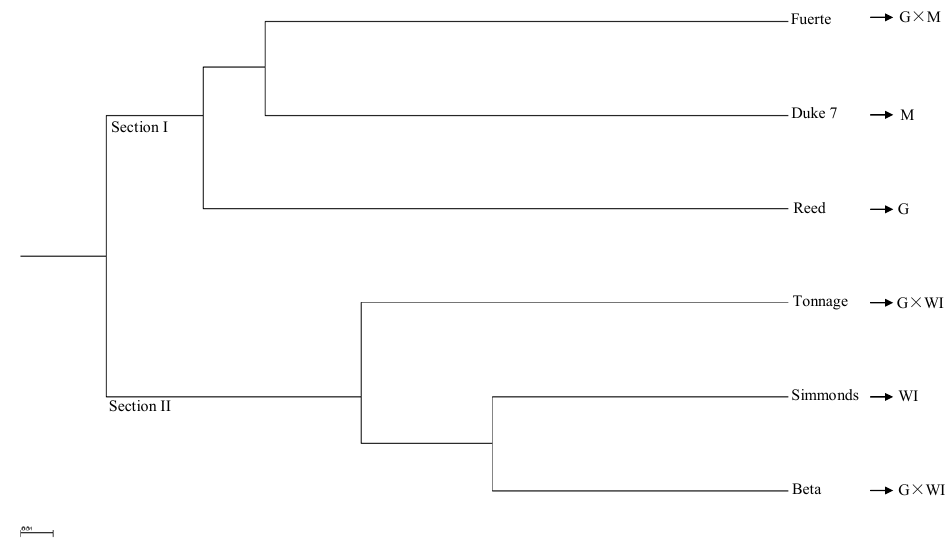
Figure 4. Unrooted unweighted pair-group method with arithmetic means (UPGMA) phylogenetic tree of six avocado accessions based on 65,535 SNPs from transcriptome data. M: Mexican, G: Guatemalan, WI: West Indian (interracial hybrids are indicated by ×).